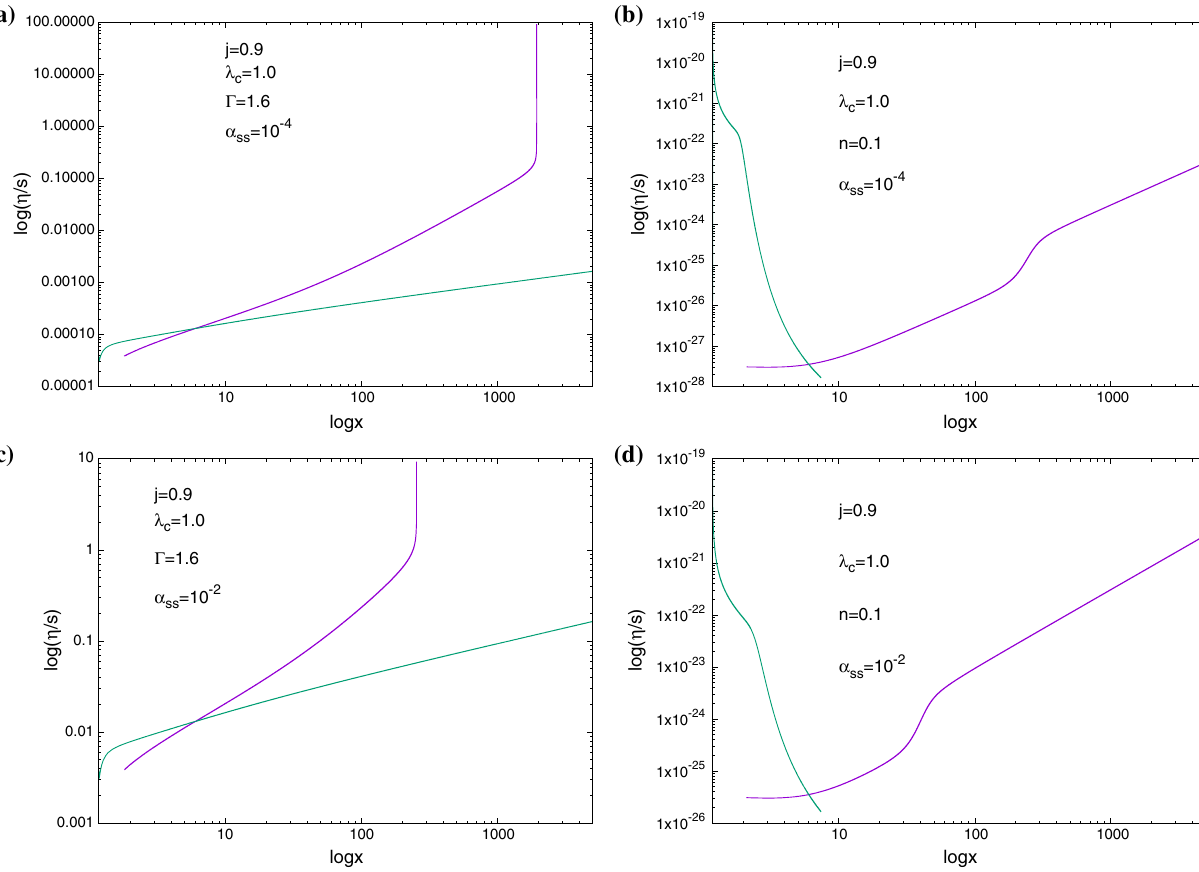
) vs log ( x ) for viscous accretion disc Fig. 3 a and c are plots of log ( η vs log ( x ) for viscous accretion disc flow with viscosity α ss = 10 − 4 s and α ss = 10 − 2 respectively, around a non-rotating BH with j = 0 . 5 flow with viscosity α ss = 10 − 4 and α ss = 10 − 2 respectively, around a ) for MCG. Accretion and wind curves are depicted by purple and green rotating BH with j = 0 . 9 for adiabatic case. b and d are plots of log ( η s lines respectively